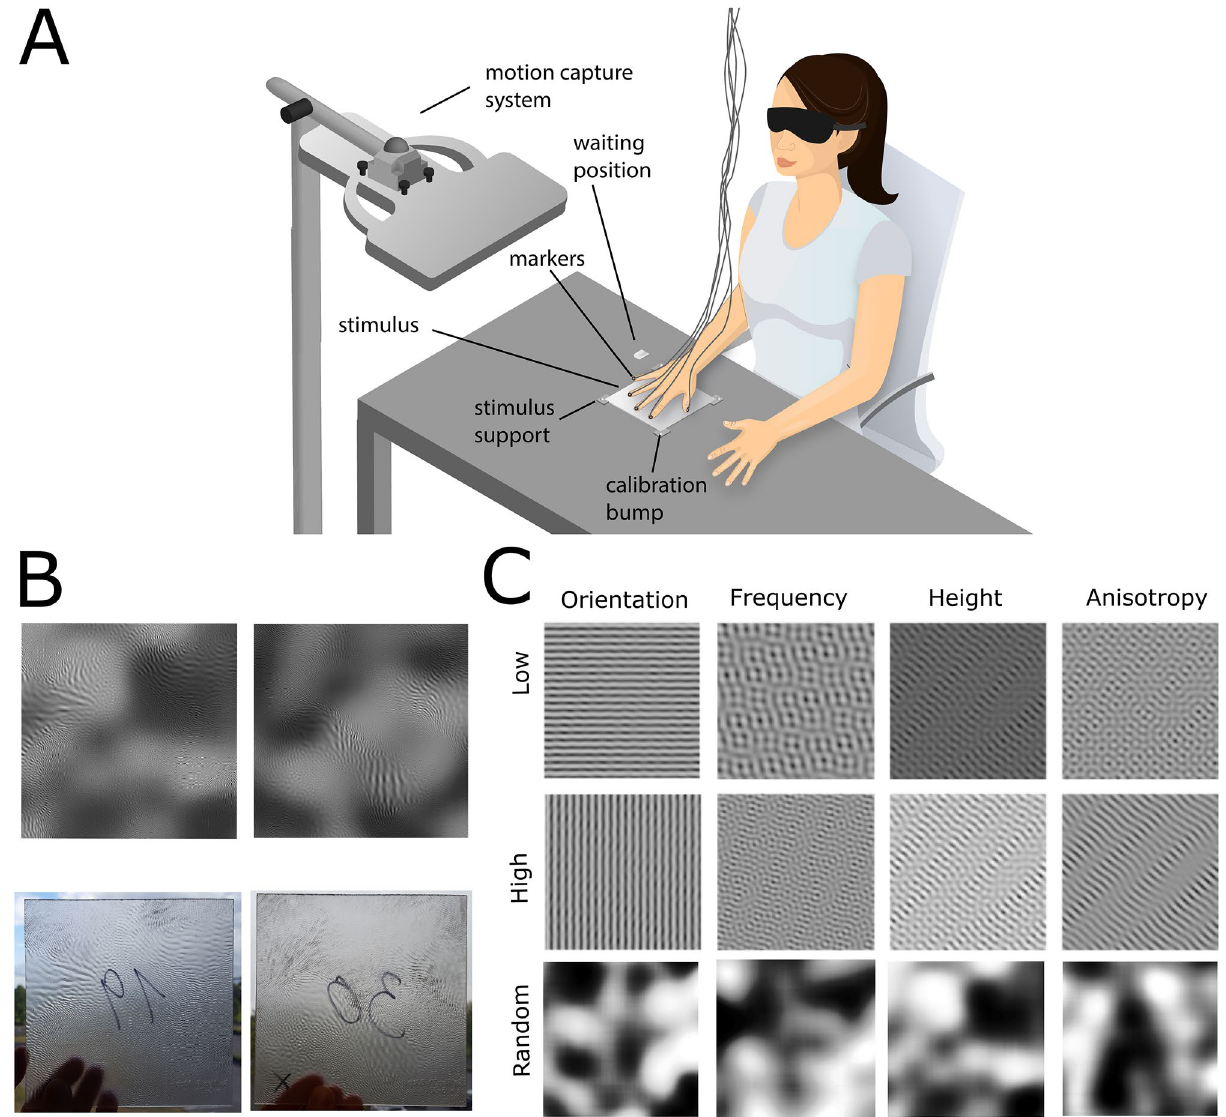
Figure 1. ( A ) Setup. Participants sat at a table together with the experimenter who positioned the stimuli in front of them. Stimuli were stabilized at the four corners. The position of each finger of the participant’s right hand was tracked with the ultrasound based motion tracking system (Zebris). Prior to the experiment the position of the right index finger was calibrated using the calibration bumps in the stimulus support corners. Between trials participants moved the hand to the waiting position marked as a finger-holder for the middle finger. ( B ) Example stimuli. Surface reliefs on top with their printed versions below. ( C ) Stimulus features used to create the stimuli: orientation direction (Orientation), spatial frequency (Frequency), surface relief height (Height) and spatial anisotropy (Anisotropy). The features are exemplified by uniform stimuli (not used in the experiment), in which all features are kept constant but one is set either to the minimum (“Low”, first row) or the maximum (“High”, second row) of the corresponding feature range. The third row (“Random”) shows four pink noise maps, one per feature, used to generate the example stimulus 19 in B